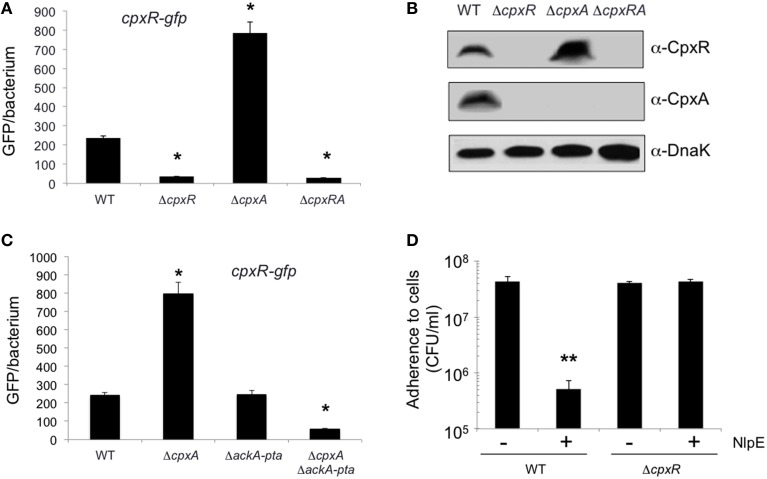
High levels of CpxR expression in ΔcpxA. (A) Expression of cpxR is derepressed in the absence of CpxA. EHEC wt (EDL933) and various cpx mutants carrying a transcriptional fusion cpxR-gfp were grown in DMEM and samples were taken at 6 h post-inoculation. The relative fluorescence intensity of bacteria was determined by flow cytometry. Between 5000 and 10,000 bacteria were analyzed to calculate the mean GFP/bacterium. (B) CpxR and CpxA proteins were analyzed by Western Blotting in wild-type and cpx derivative mutants. Samples were taken at 6-h post-inoculation and were used anti-CpxR and anti-CpxA antibodies. (C) High expression of cpxR in the absence of CpxA is dependent on both AckA and Pta enzymes. EHEC wt (EDL933) and various ackA-pta mutants carrying a transcriptional fusion cpxR-gfp were grown in DMEM and samples were taken at 6 h post-inoculation. (D) Quantification of bacterial adherence upon overexpression of NlpE. The indicated strains were incubated with HeLa cells for 6 h and the adherent bacteria expressed as CFUs after plating serial dilutions. NlpE was overexpressed with 50 μM IPTG. The data are representative of a least three experiments performed in triplicate. Adherence statistically different with respect to that shown by the WT strain (*p < 0.05; **p < 0.01).